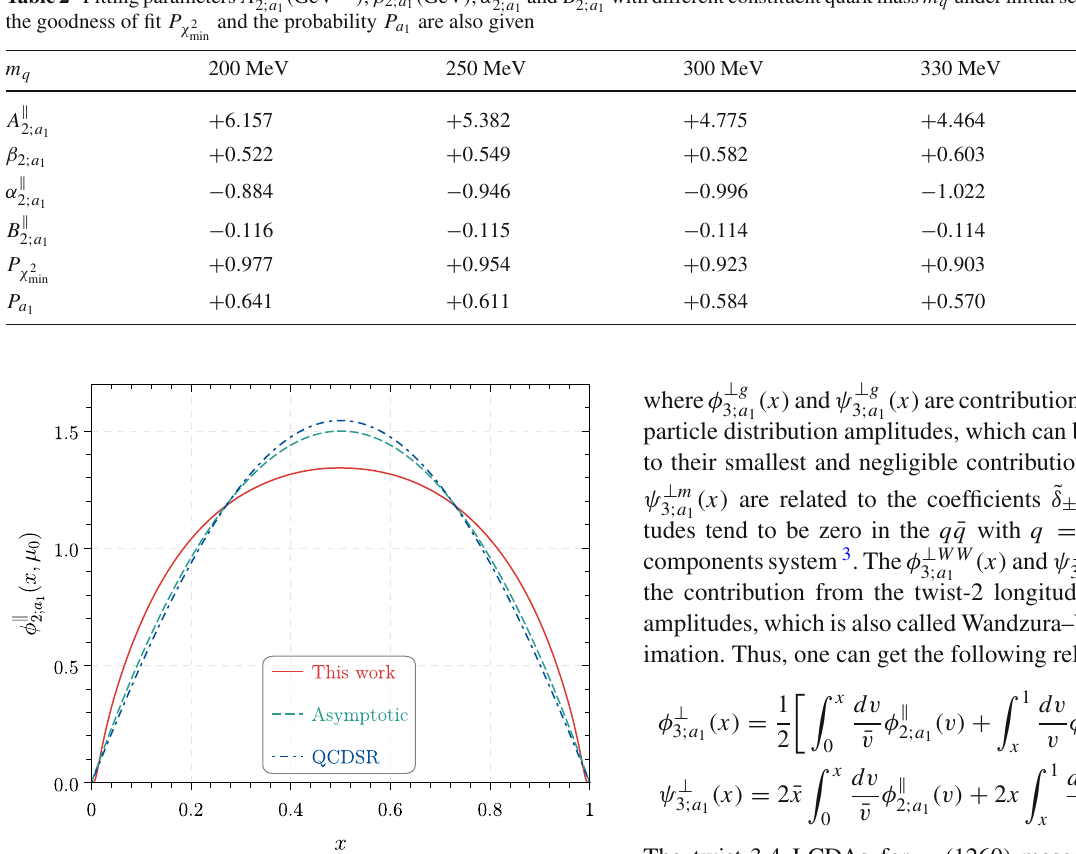
(cid:3) (cid:3) ( GeV − 1 ) , β ( GeV ) , α (cid:3) and B with different constituent quark mass m q under initial scale μ 0 . Meanwhile, 2 ; a 1 2 ; a 1 2 ; a 1 2 ; a 1